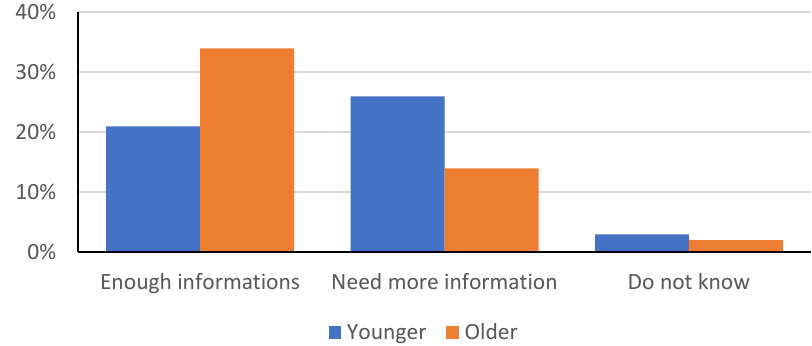
Figure 2. Satisfaction with the quantity of information.